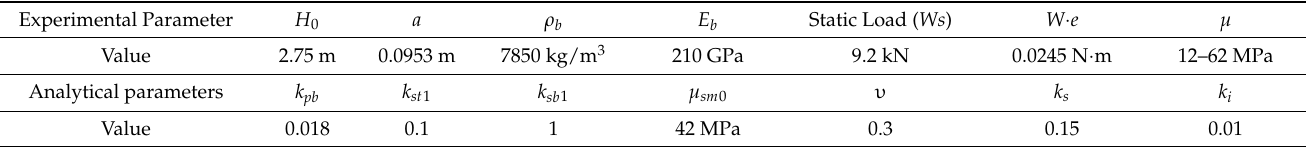
Table A2. Parameters in Figure